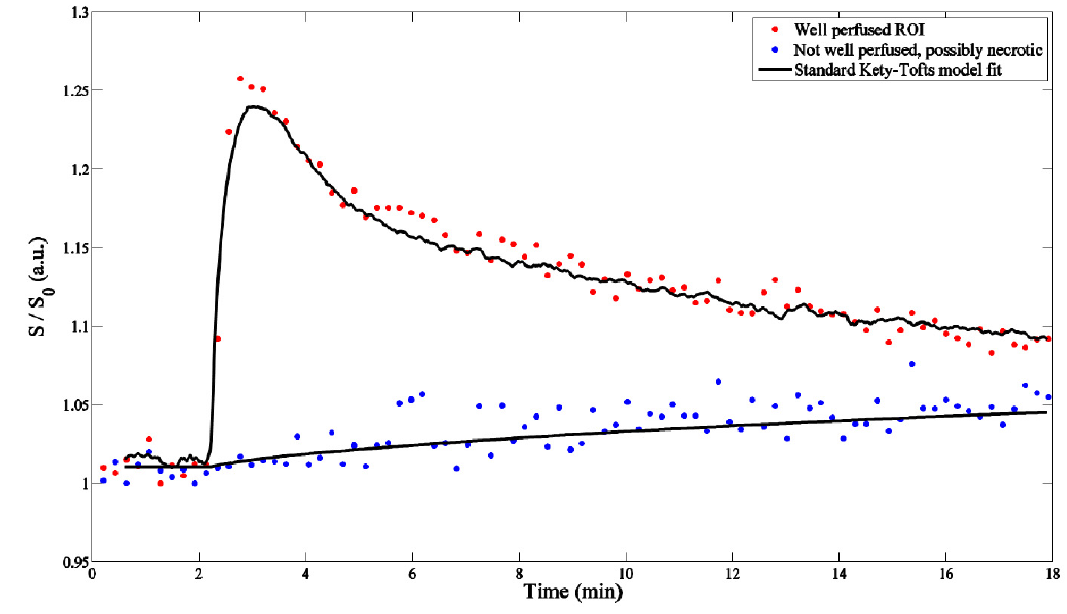
Figure 6. Representative signal intensity curves from DCE-MRI data demonstrating dynamic time courses from a well perfused region and the potential effect of contrast agent diffusion in the extravascular space. Time courses are also shown with a curve fit from standard Kety-Tofts model; K trans (min − 1 ) is 0.92 and <0.001 (almost zero) for the well perfused and necrotic region, respectively, v is 0.44 and 1.6 for the well perfused and e necrotic region, respectively. The effect of diffusion can be seen by the persistence of the contrast agent in the latter portion of the curves, specifically in the curve labeled as “possibly necrotic”. This diffusion effect causes the model to return v values that are e unphysiological ( i.e. , v > e